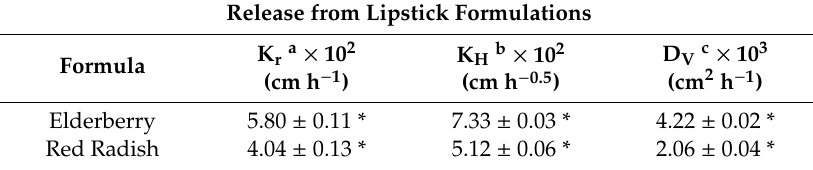
coefficient within lipstick (Equation A6).